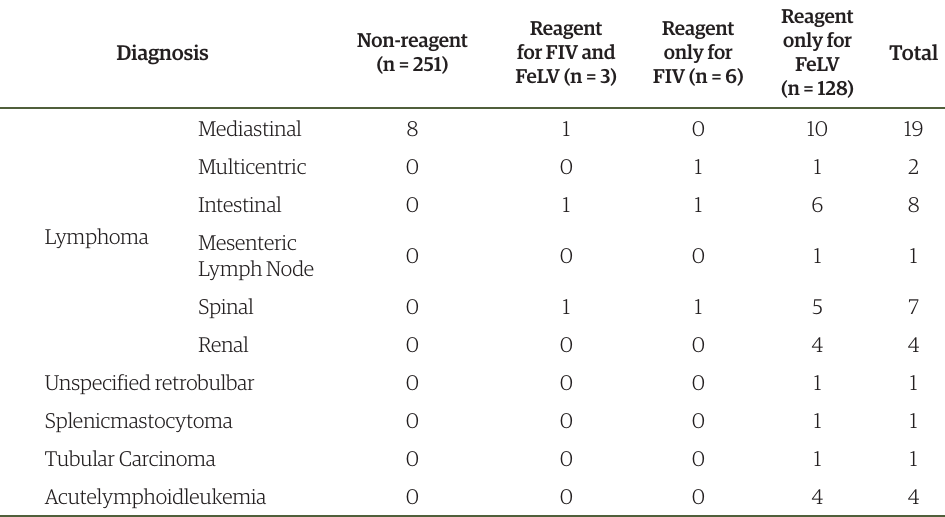
Table 1. Frequency of neoplasms in cats submitted to the SNAP FIV / FeLV IDEXX test between 2014 and 2016 in Grande Vitória -